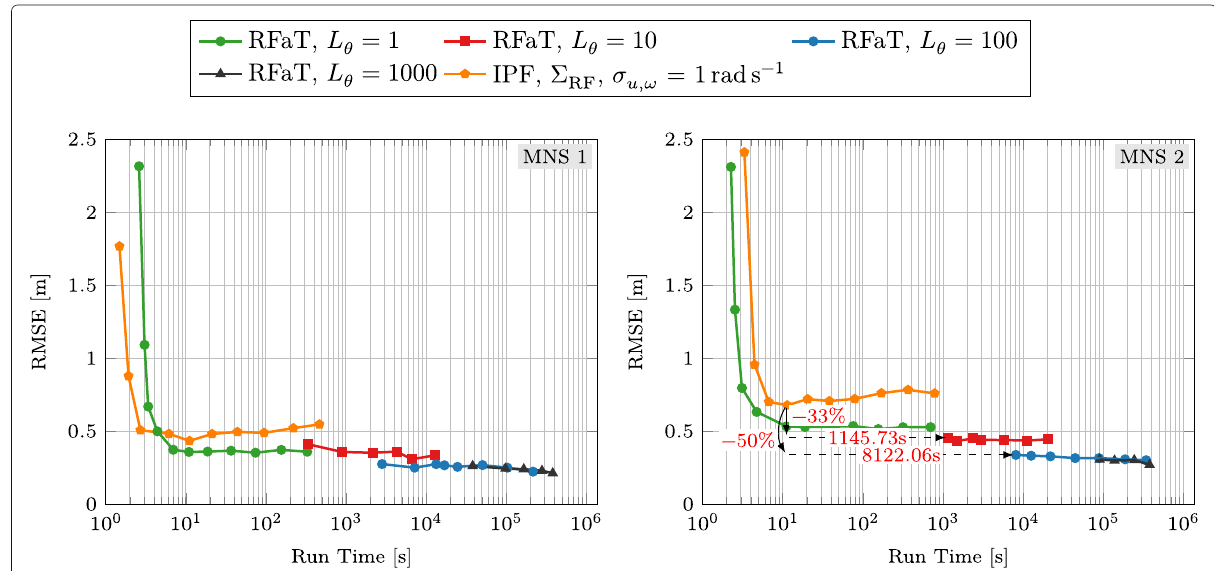
Fig. 11 Run-time comparison between the RFaT and IPF algorithms for various L θ configurations. The left panel shows the results for MNS 1, and the right panel shows the results for MNS